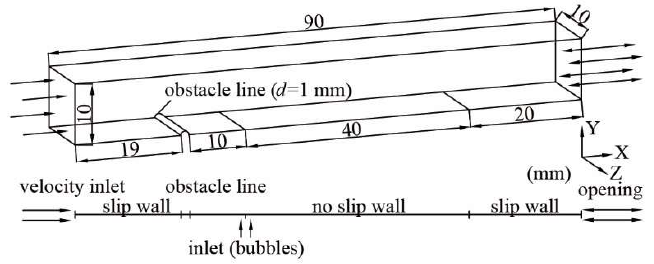
Figure 1. Schematic of geometrical and boundary conditions.